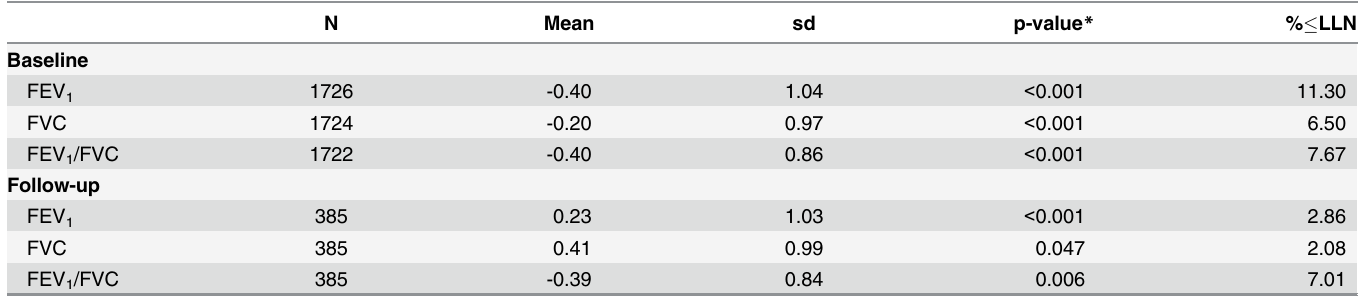
For our study population, the predicted means of the GLI reference values were approximately linear with age (Fig 2). The age-related slope of the predicted means of the GLI reference values and FVC measured longitudinally in the HNSW over a fitted well to the mean slope of FEV 1 period of more than 20 years. Furthermore, all mean changes of z-scores differed less than 0.5 from zero (p < 0.01) which means that the longitudinal fit was good (Table 4). Table 3. GLI-based z-scores of all healthy never-smoking women (HNSW) grouped by time of examination (baseline and follow-up). Two one-sided tests for equivalence were performed to establish equivalence between the mean z-score of the GLI reference population and SALIA (p < 0.05).